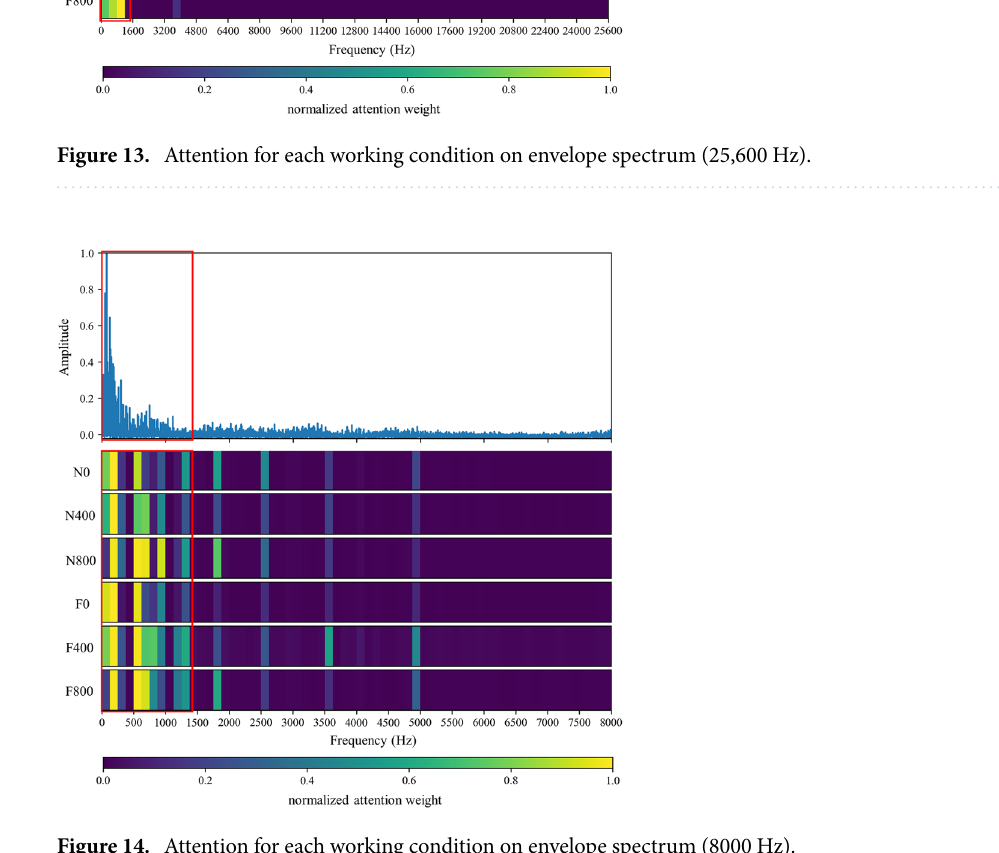
Figure 14. Attention for each working condition on envelope spectrum (8000